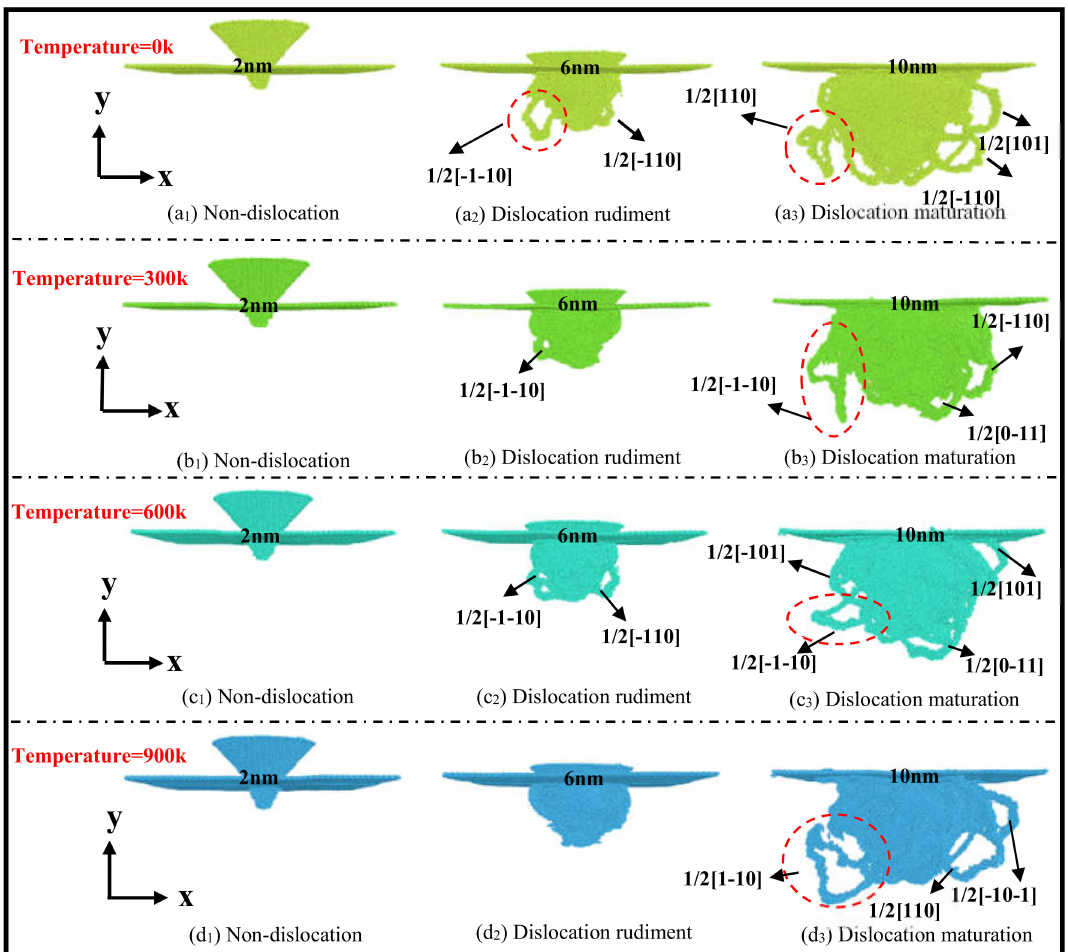
Figure 4. Flowchart of dislocation evolution and